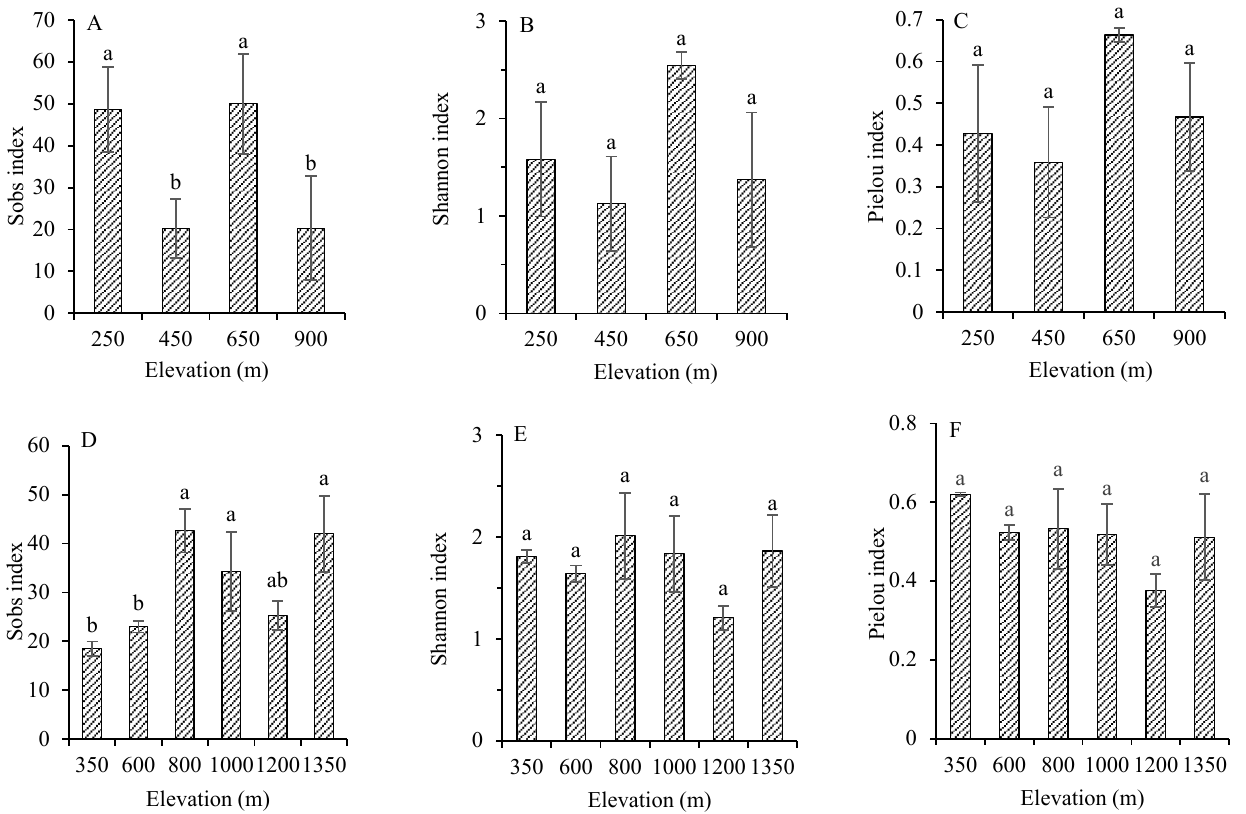
Figure 4. Differences in fungal diversity indices, including Sobs, Shannon and Pielou indices, on Mt. Diaoluo ( A – C ) and Mt. Jianfengling ( D – F ). Deviation bars represent standard errors. Different lowercase letters (a, b) above each column indicate significant differences ( p < 0.05).